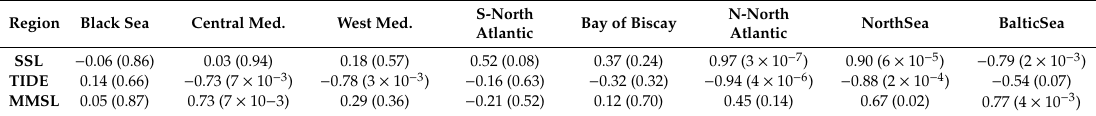
Figure 8. Average monthly fraction of each components’ variance in the ETWL along the coastline (closest 1° × 1° tile) of each oceanographic region (Figure 8a to Figure 8j). The monthly relative frequency of storm impacts at each area (blue polygon) is also shown. Table 1. Rank correlation coefficient between the average monthly fraction of components’ variance of SSL, TIDE and MMSL along the coastline (closest 1° × 1° tile) of each oceanographic region and the relative monthly frequency of the storm events database. p-value is given in brackets.